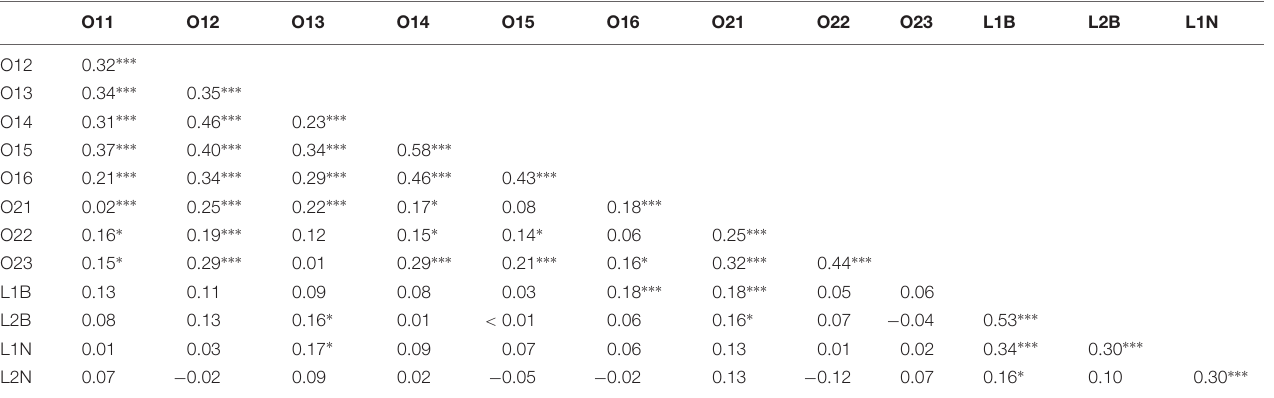
TABLE 6 | Intercorrelations of all variables in the job loss group. O11 O12 O13 O14 O15 O16 O21 O22 O23